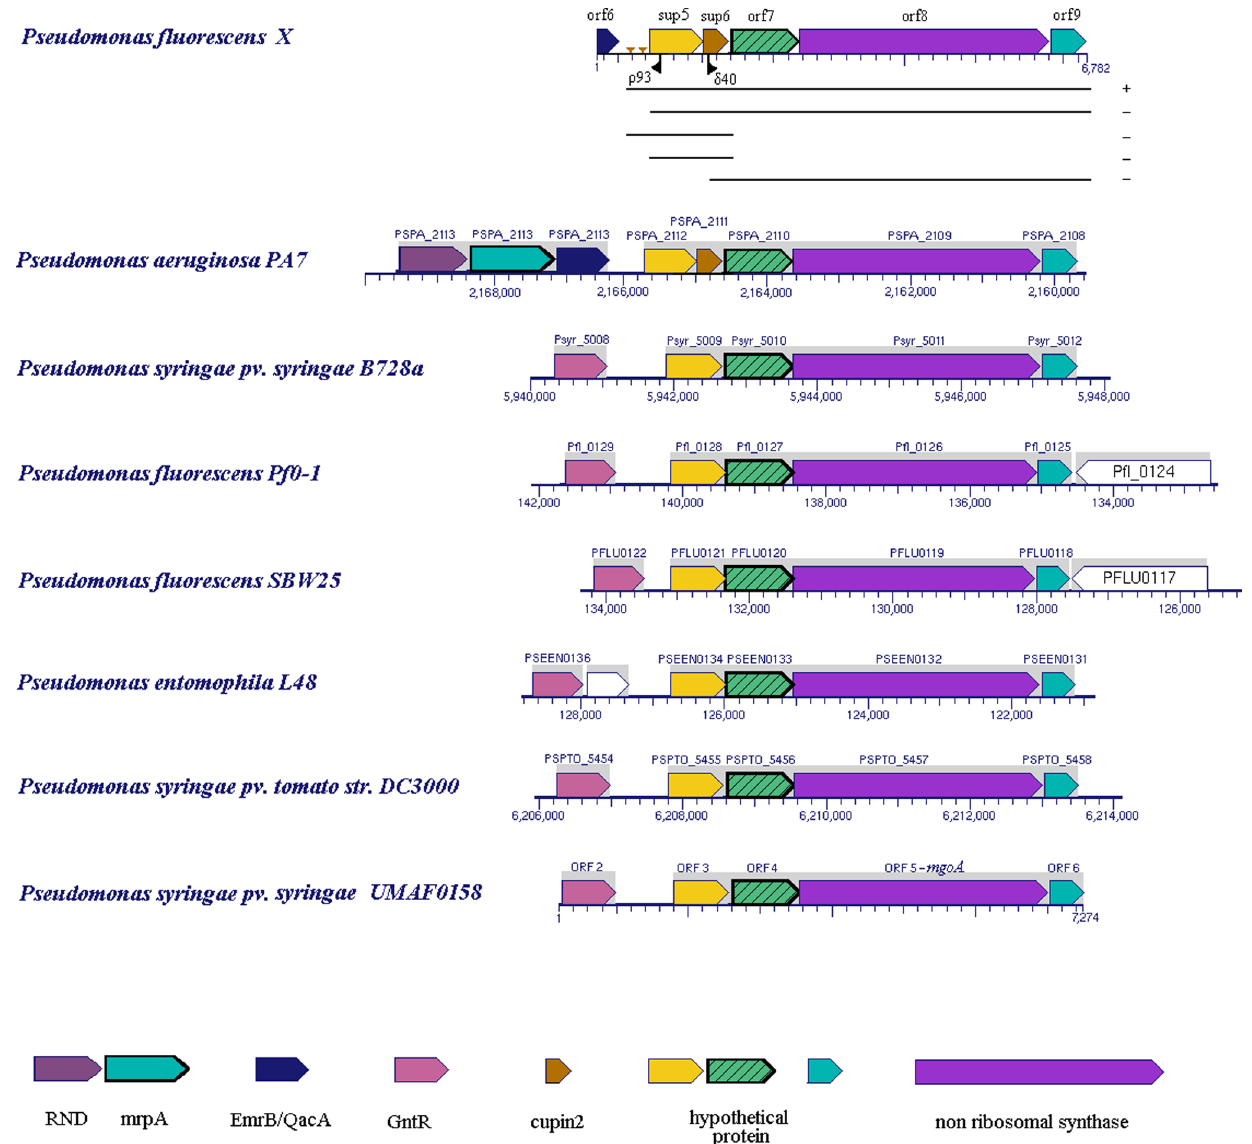
Figure 2. Arrangement of the genes in the genomic locus of sup 5 and sup 6, compared to other Pseudomonas strains, and complementation analysis of the region. The lines beneath the genomic of Ps. fluorescens X represent regions of this locus that were PCR- amplified, cloned into pBBR1MCS5 and tested for complementation. Ability to complement is noted with plus ( + ) or minus ( 2 ). Putative ORFs are indicated by thick coloured arrows on a line. Genes that might be organised in a putative operon are enclosed by a grey frame. The direction of the plasposon Tn 5 -RL27 insertion in mutants d 40 and r 93 is indicated with a black arrow beneath the sequence ( c ). Predicted sites for the unique putative promoter and operator are also marked ( ). Size, genomic location and locus tag of the different ORFs sequenced in Ps. aeruginosa PA7, Ps. fluorescens Pf0–1, Ps. fluorescens SBW25, Ps. entomophila L48, Ps. syringae pv. syringae B728a, Ps. syringae pv. tomato DC3000 and Ps. syringae pv. syringae UMAF0158 are